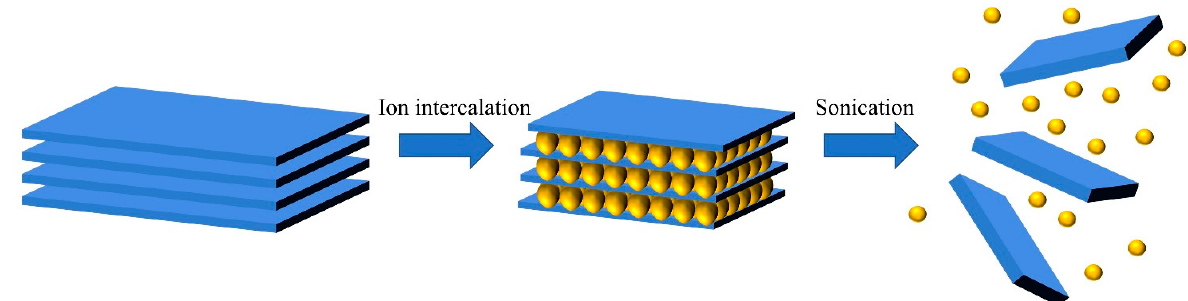
Figure 2. Schematic description of the main liquid exfoliation mechanisms.